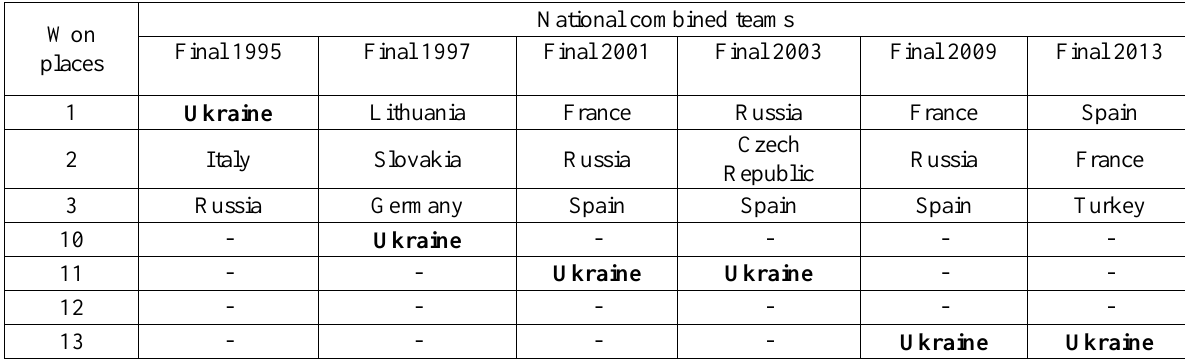
Results of women’s national combined team of Ukraine (basketball) in finals of European championships 1995-2013,